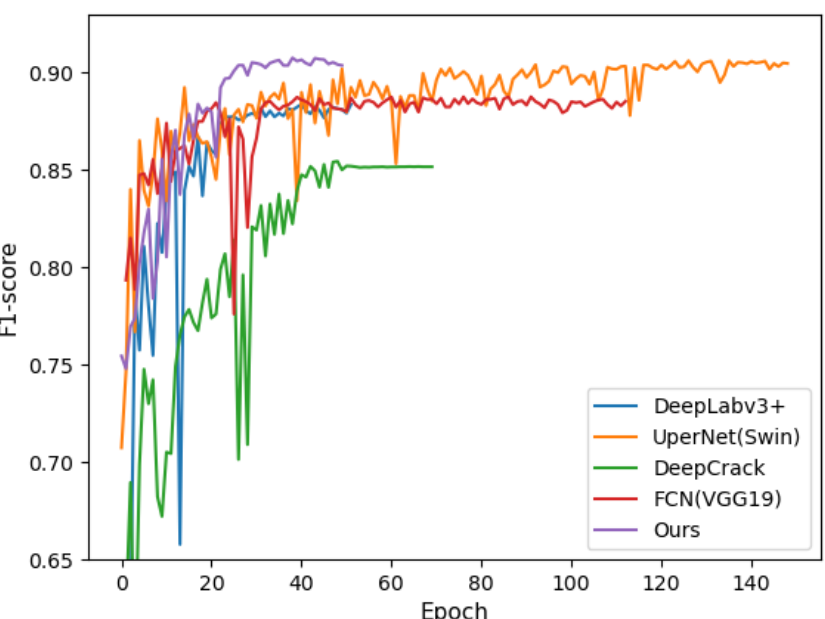
Figure 8. Validation F1-score of different models on our tunnel leakage dataset.